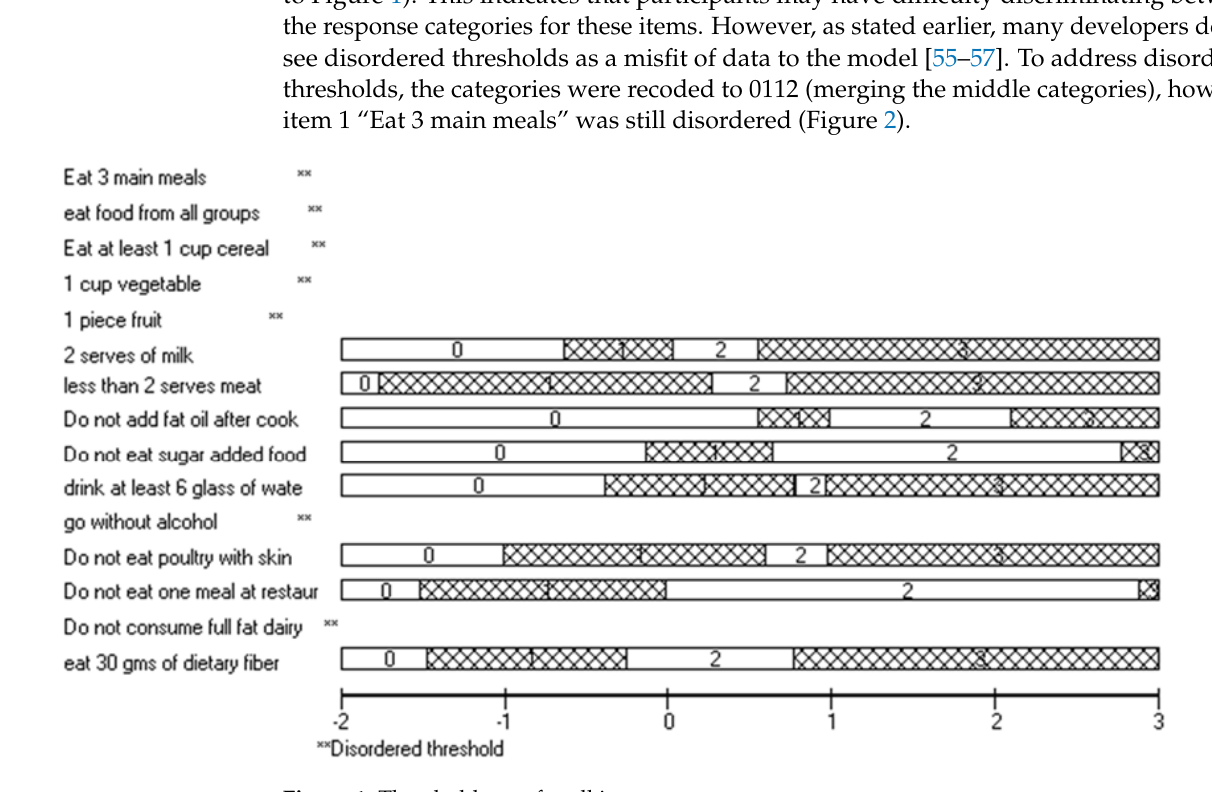
Figure 2. Threshold map after collapsing middle categories, notice that “Eat 3 main meals” is still disordered. 3.5. Refinement of Model Several refinements were trialed to ascertain the best model fit, see Table 2. Rescoring/collapsing categories to address disordered thresholds was trialed, because some model and software developers argue that there are certain circumstances where disordered thresholds may reflect a flaw in the scale [55]. After re-scoring categories, how- ever, there was a drop in item–trait interaction χ 2 . Even after collapsing the middle cate- gories, item 1 was still disordered. The fit statistics were calculated with item 1 deleted, however, there was no substantial increase in model fit, so it was decided to retain item 1 in the scale. As previously stated, there were problems with the fits for item 10 (which had fit residual of 2.573) and a Chinese male in the 60–69 age group and a non-Chinese male in the 60–69 age group, having fit residuals of − 3.461 and 3.402, respectively, which are